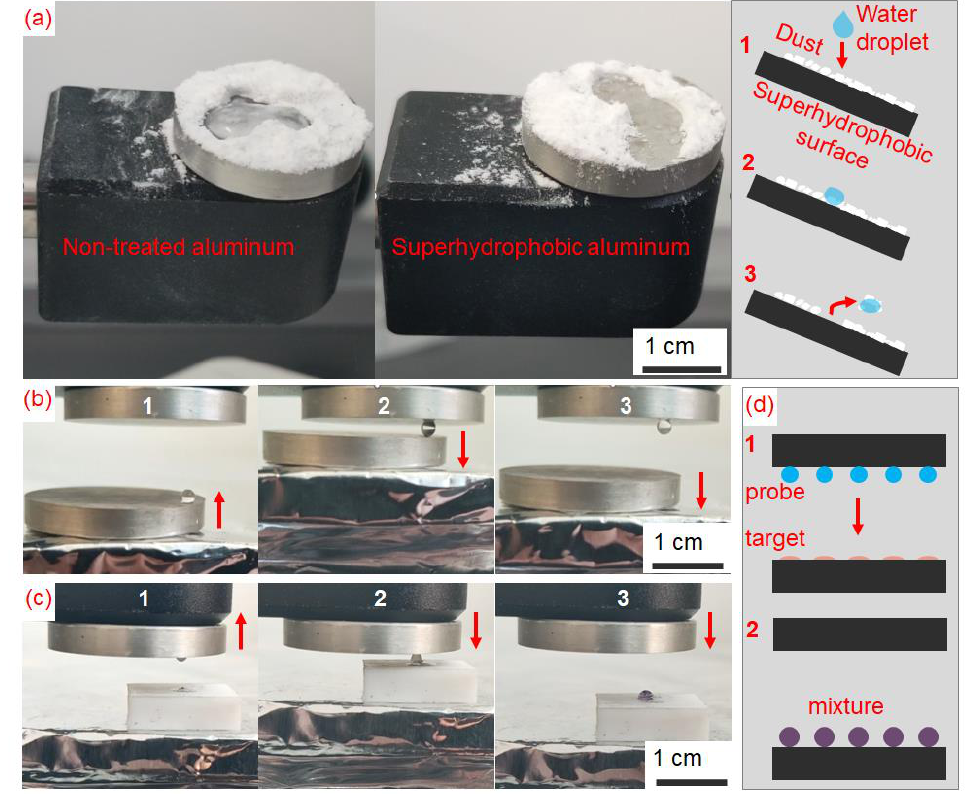
Figure 6. ( a ) Self-cleaning effect on non-treated and superhydrophobic aluminum surfaces with a describing schematic on the right side at three different time points, labeled as 1, 2, and 3 in sequen- tial order (the red arrows showed the movement directions of the water droplet), ( b ) Droplet capture as a “droplet tweezer” on superhydrophobic aluminum with the different controlling level of water adhesion shown in three images taken from Video S4 at three different time points, labeled as 1, 2, and 3 in sequential order (the red arrows showed the movement directions of the lower linear trans- lation stage), ( c ) Droplet mixing between a water droplet and an oil droplet shown in three images taken from Video S4 at three different time points, labeled as 1, 2, and 3 in sequential order (the red arrows showed the movement directions of the lower linear translation stage), and ( d ) a conceptual depiction of droplet array manipulation for droplet mixing applications with the initial state labeled as 1 and the final state labeled as 2 (the red arrows showed the movement directions of the upper linear translation stage). From the technological transfer point of view, when coordinating a single pulse laser with the help of the translation system for practical scalable wettability modifications at